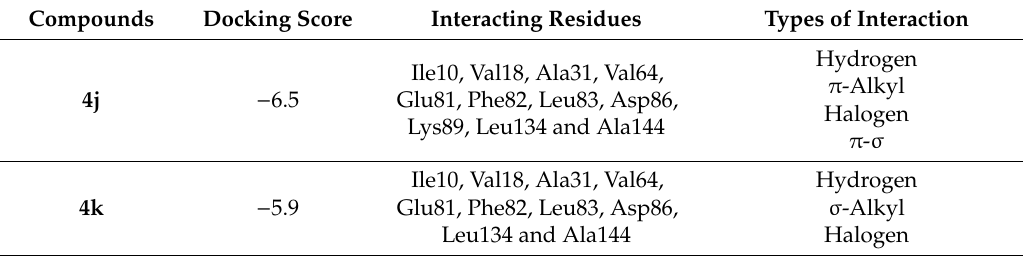
Table 4. Docking score, interacting residues and types of interaction mediated by 4j and 4k with the ATP binding pocket of CDK2 protein